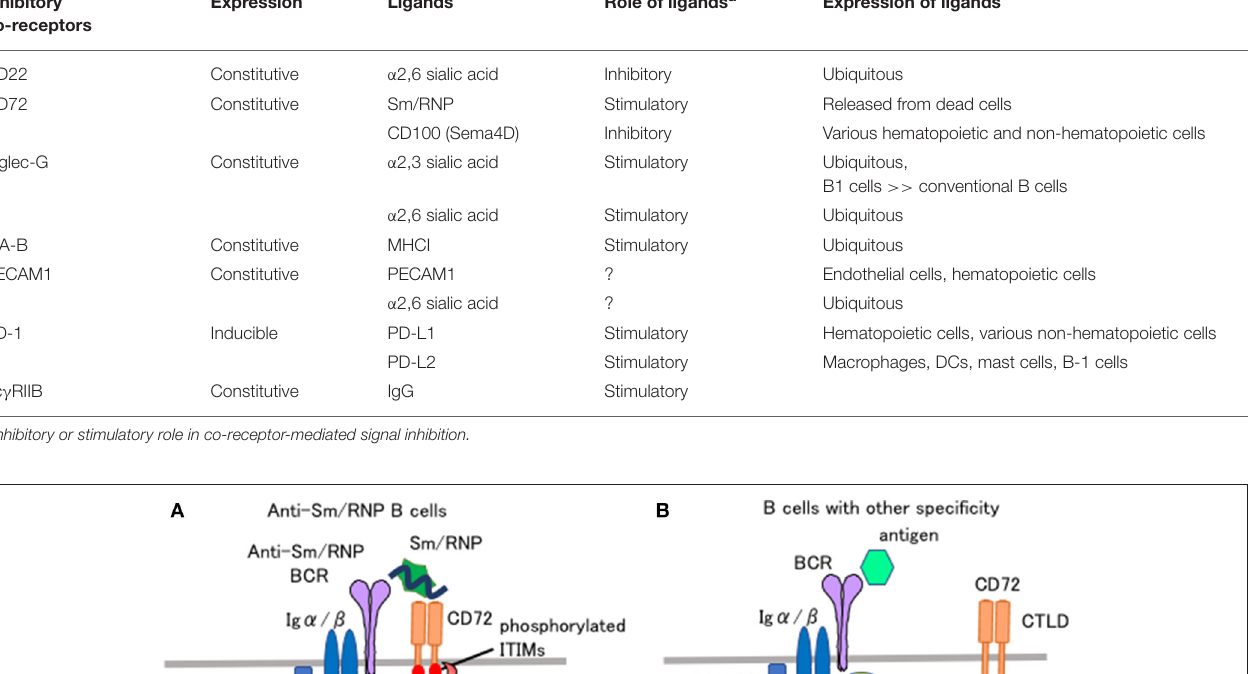
TABLE 2 | Inhibitory co-receptors and their ligands. Inhibitory co-receptors